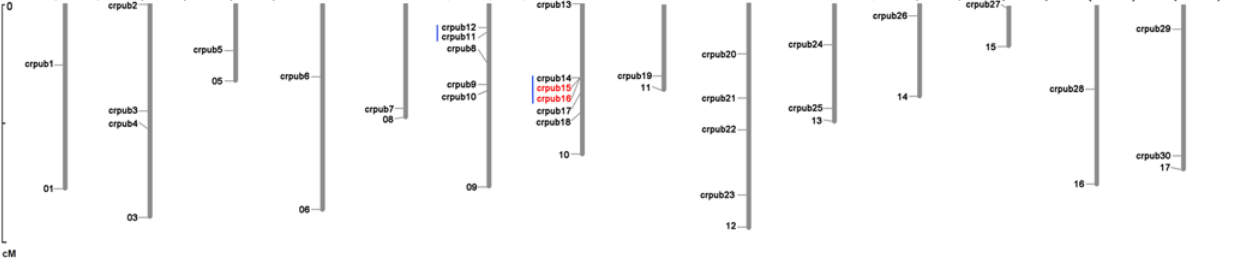
Fig 4. Chromosomal locations of the 30 CrPUB genes. The locations of the 30 CrPUB genes were drafted using MapInspect software, and their duplication patterns were detected using a synteny plot in Plaza. The chromosome numbers and sizes are shown at the top of each chromosome. Each CrPUB gene on the chromosome is displayed on the left side according to the approximate physical location. The tandem gene duplications are indicated in red. The blue line indicates a gene